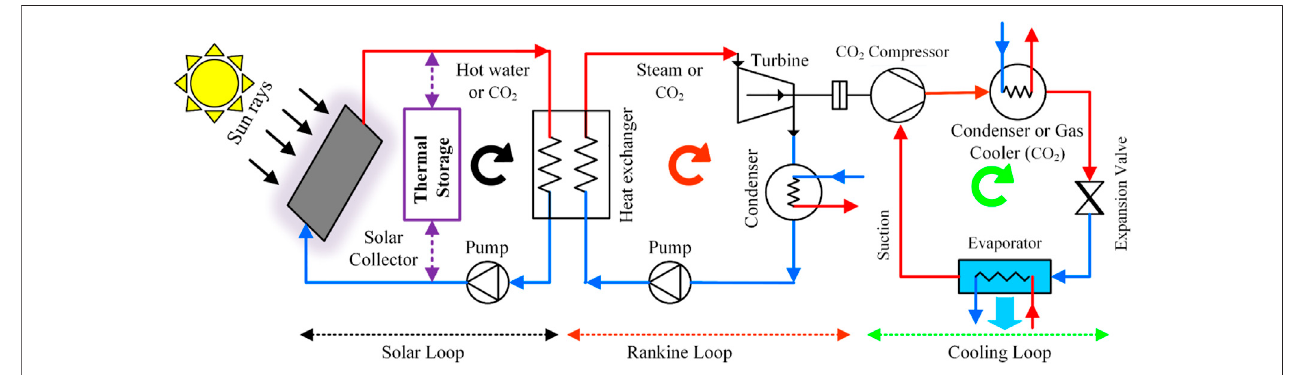
FIGURE 2 | Solar thermal cooling through Rankine cycle (Khan,